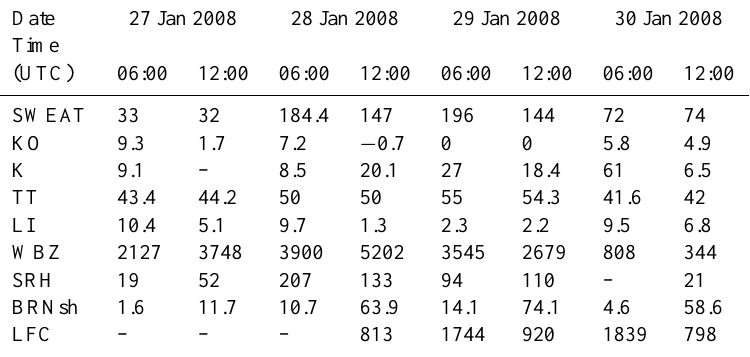
Table 1. Thermodynamic indices calculated for Athalassa radiosonde station during the study period, for 06:00 and 12:00UTC. Based on literature, numbers in red indicate strong probability and numbers in green moderate probability for thundery activity.